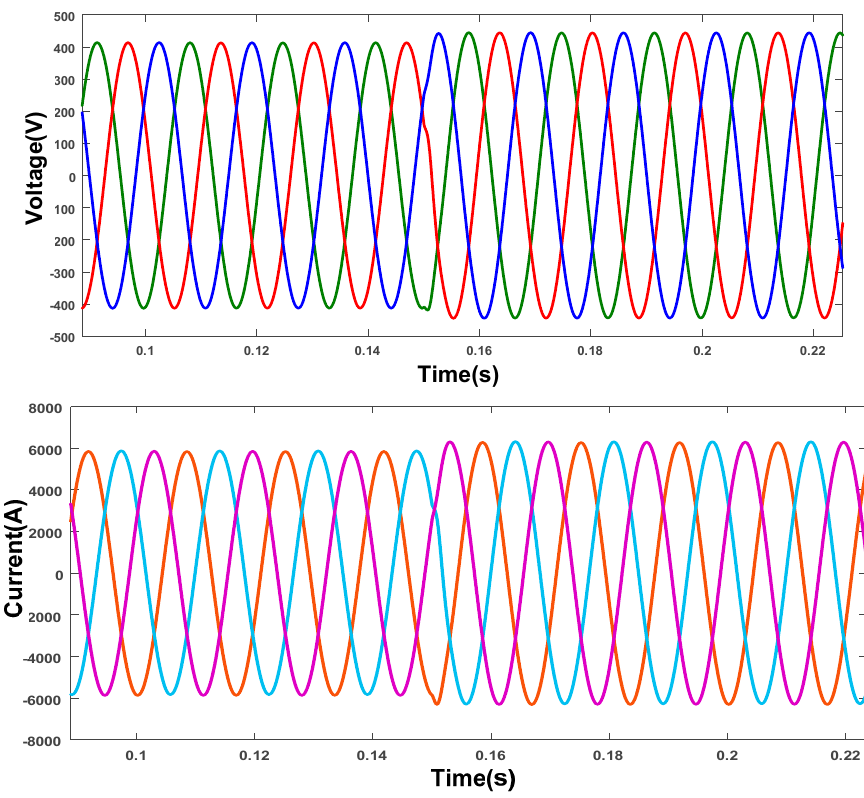
Figure 18. The load side voltage and current.